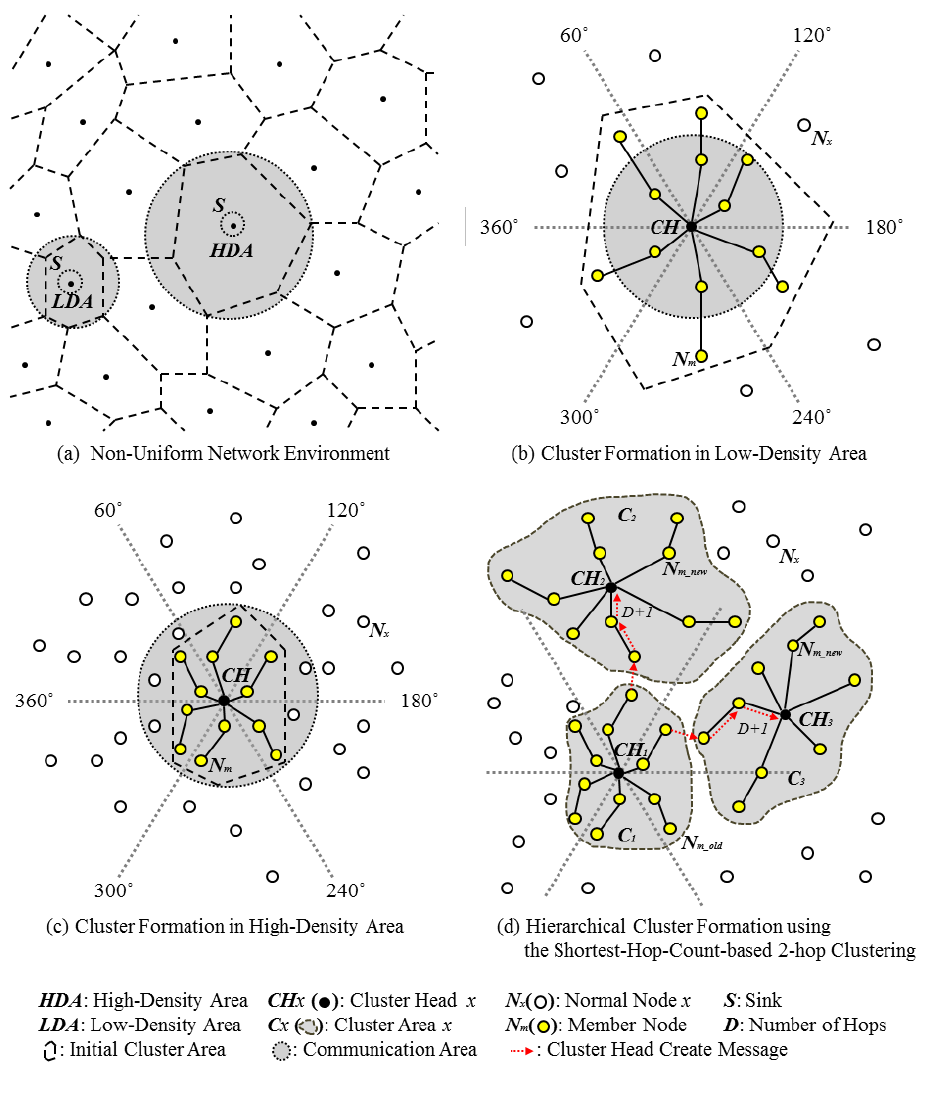
Figure 1. Hierarchical uniform cluster formation. ( a ) Non-uniform network environment. ( b ) Cluster formation in Low-Density Area. ( c ) Cluster formation in High-Density Area. ( d ) Hierarchical cluster formation using the shortest-hop-count-based